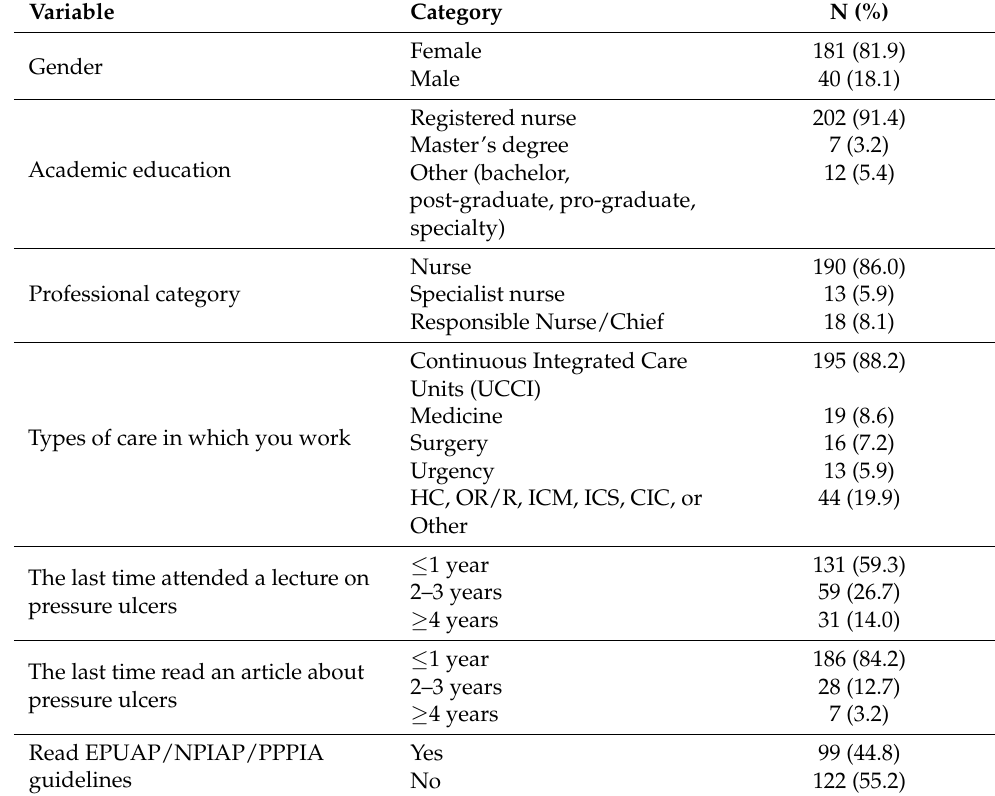
Table 1. Socio-demographic characteristics of the participants ( n =